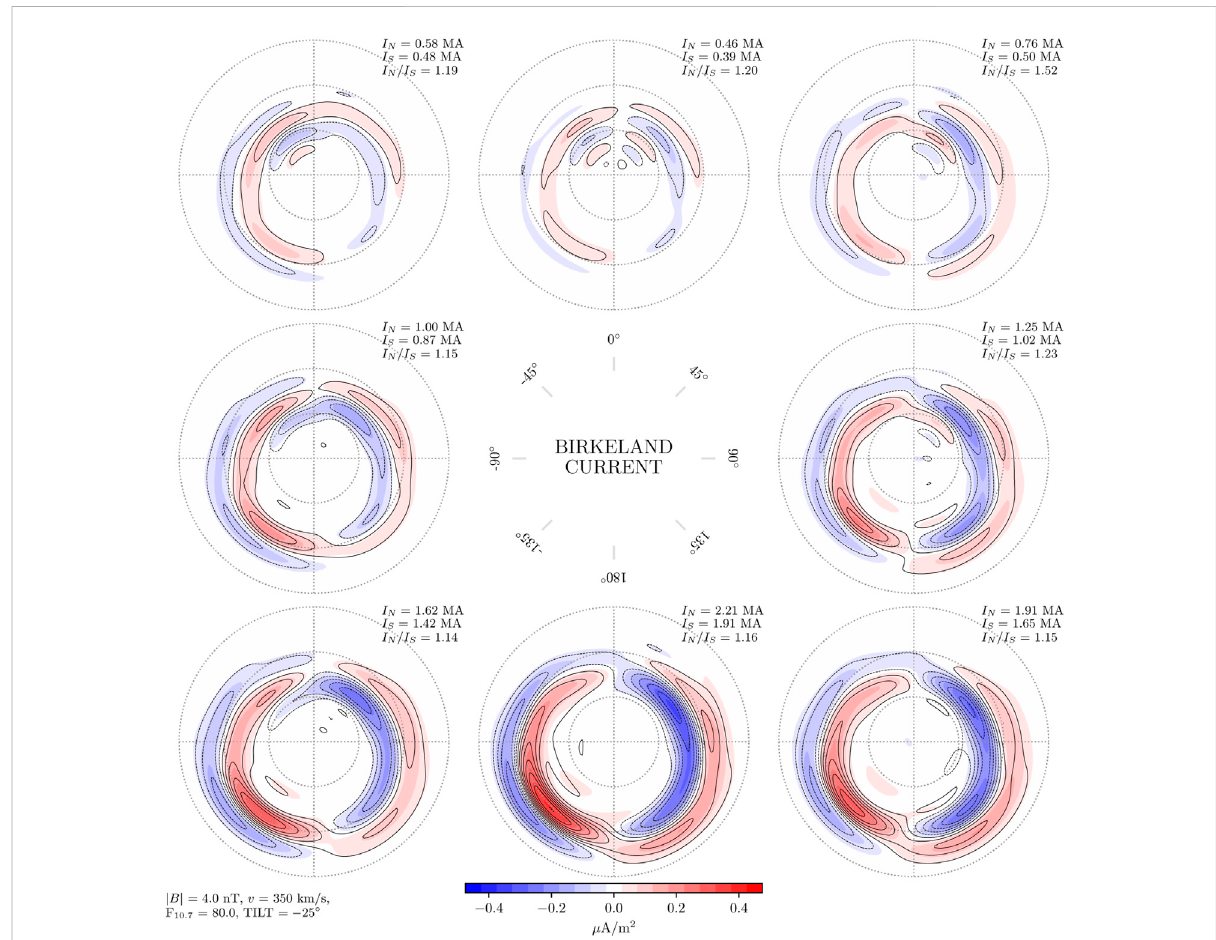
FIGURE 2 AmplitudeofBirkelandcurrentsintheNorthernHemisphere(coloredcontours)andSouthernHemisphere(blackcontourlines)asafunctionof IMF clock angle for dipole tilt angle ψ = − 25 ° , where the signs of B y and ψ are reversed for the Southern Hemisphere. The spacing between both contours and contour lines is 0.05 μ A/m 2 . In this fi gure, the mean hemispherically integrated current (top right corner of each panel) in the Northern Hemisphere is 18% stronger than in the Southern